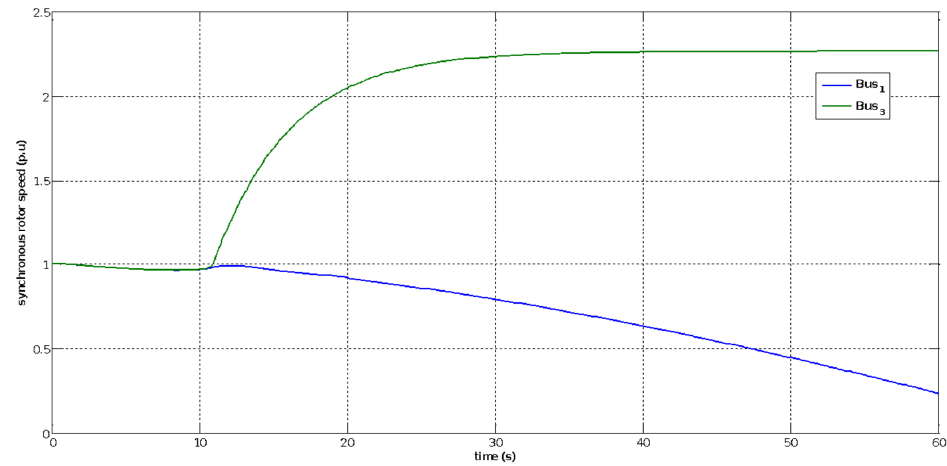
Figure 34. Synchronous rotor speed response of the swing bus 1 and bus 3 under three ‐ phase short circuit bus 15.